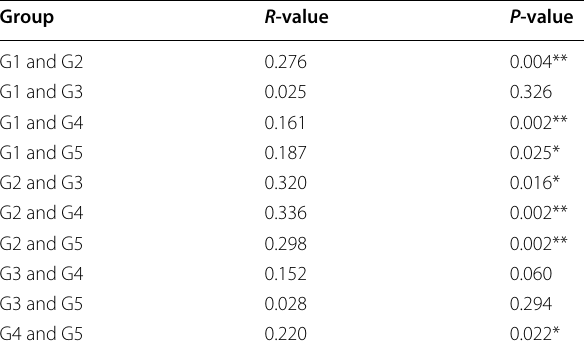
Table 1 An analysis of similarities (ANOSIM) was calculated at the OTU level based on Bray–Curtis distance between each two